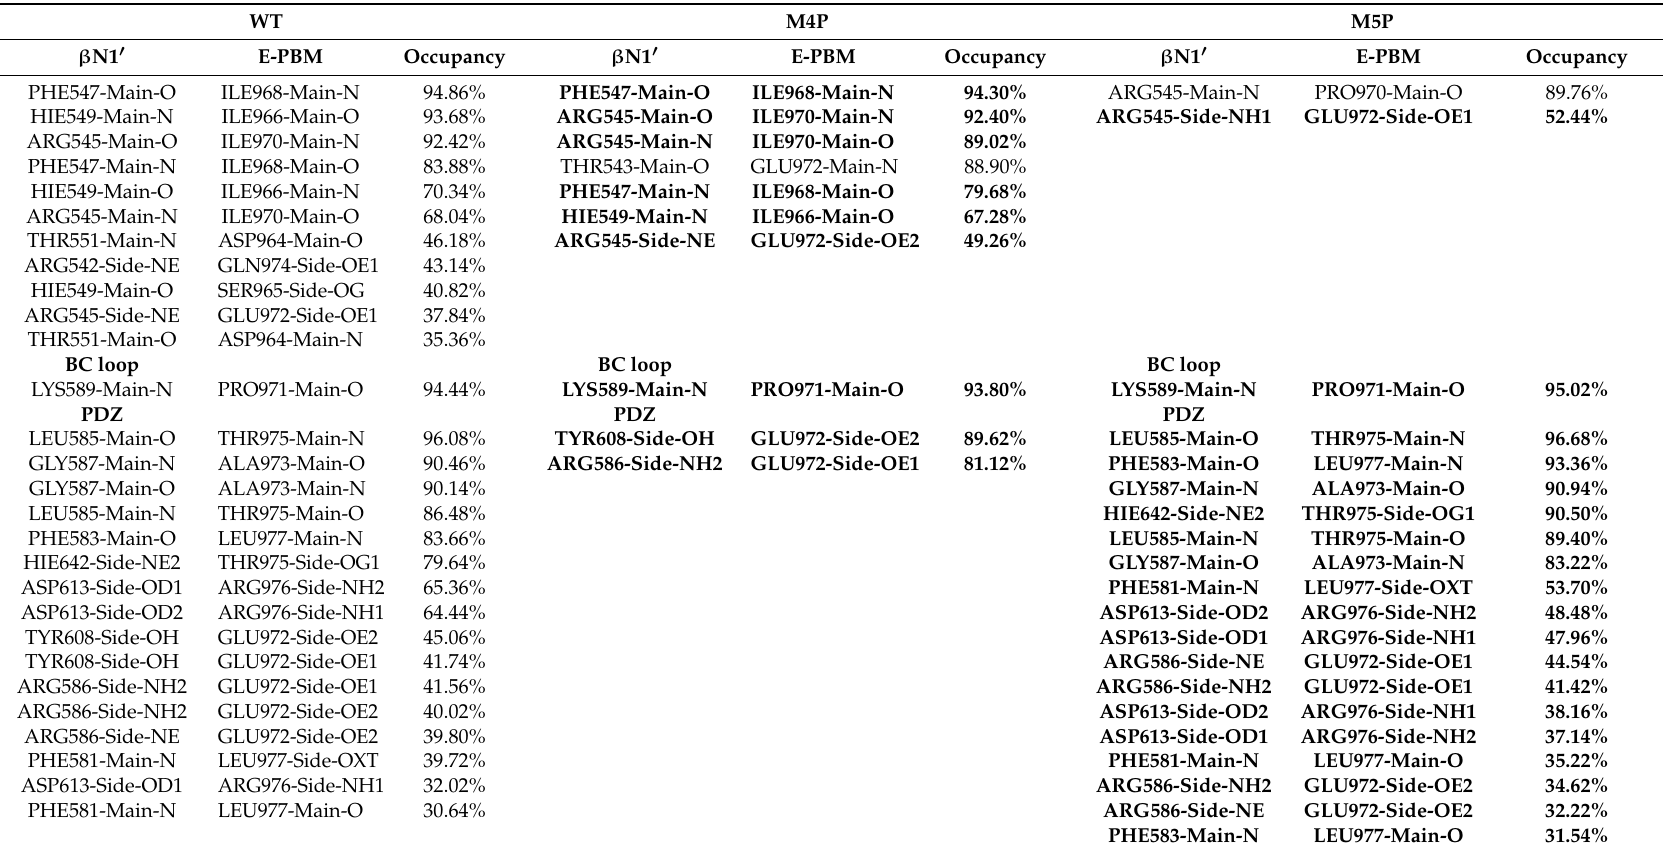
Table 2. The hydrogen bonds formed by Shank N-PDZ and SAPAP E-PBM with occupancy over 30% for WT, M4P and M5P system. WT M4P